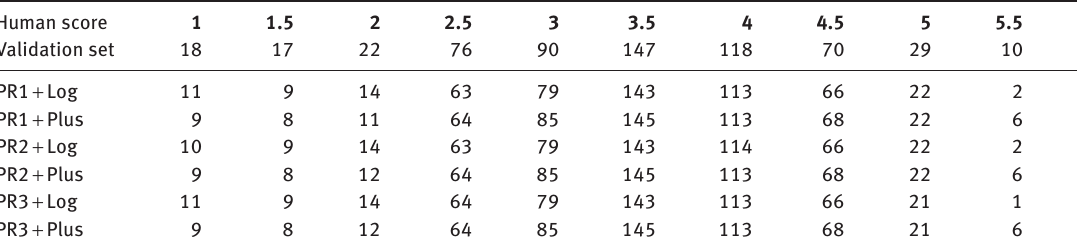
Table 3: Scoring Details of Modified CLSI (LM: News).